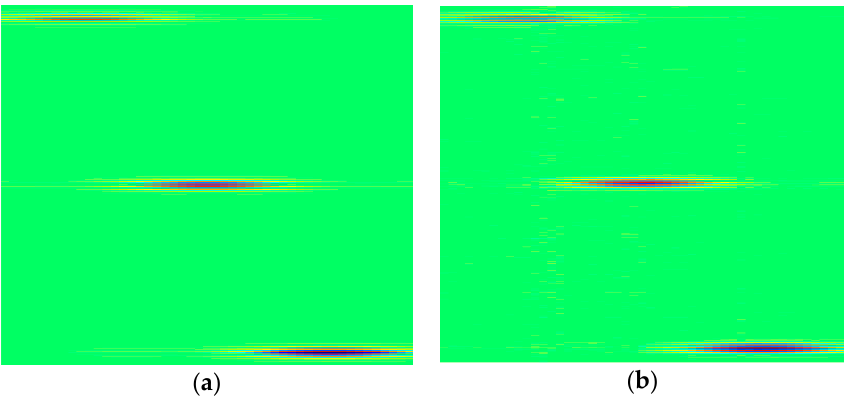
Figure 8. The recovery results of 20 MHz SR simulated image in frequency domain, ( a ) CR = 70%, PSNR = 49.73 dB; ( b ) CR = 80%, PSNR = 44.83 dB.